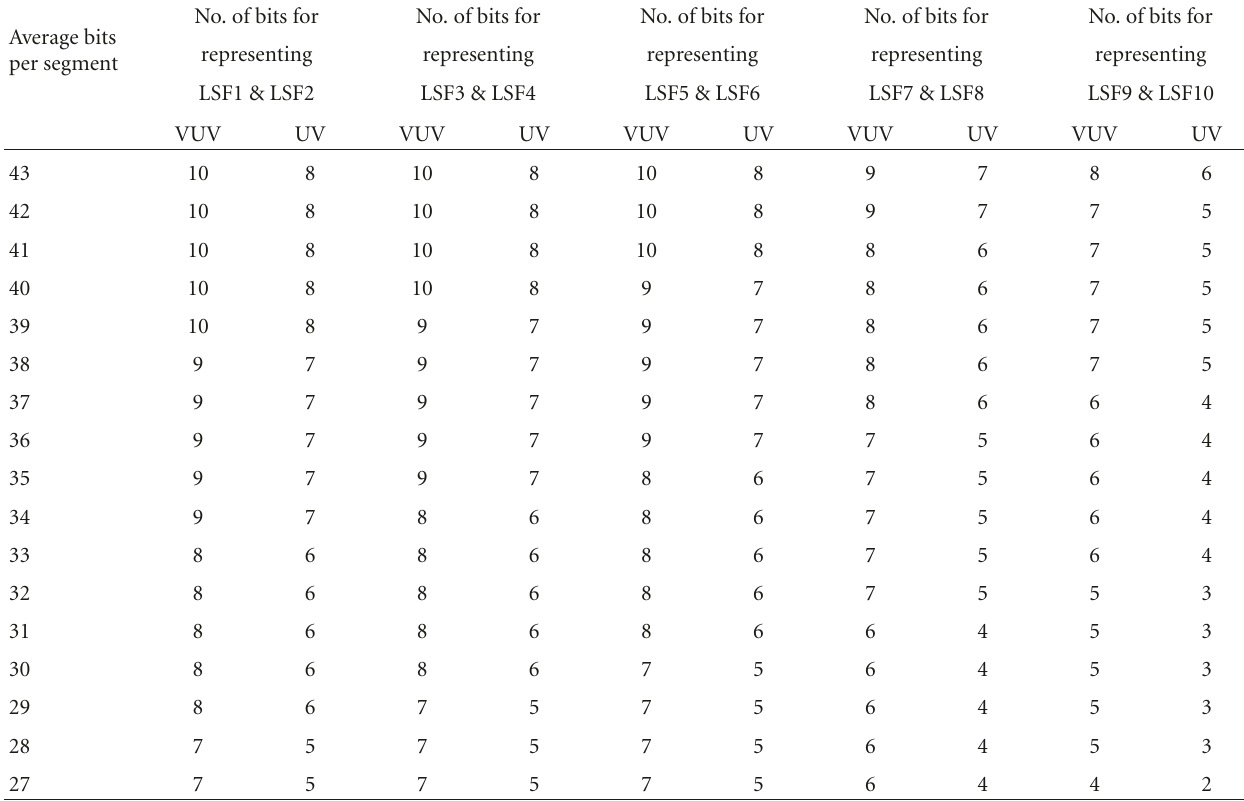
Table 2: The bit allocation used for embedded quantization at di ff erent rates. UV and VUV correspond to unvoiced and mixed voicing codebooks,